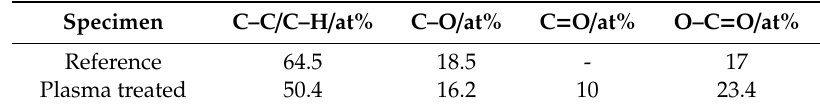
Table 1. XPS data of the C1s carbon peak from fitted Voigt profiles of PLA WPC before and after plasma